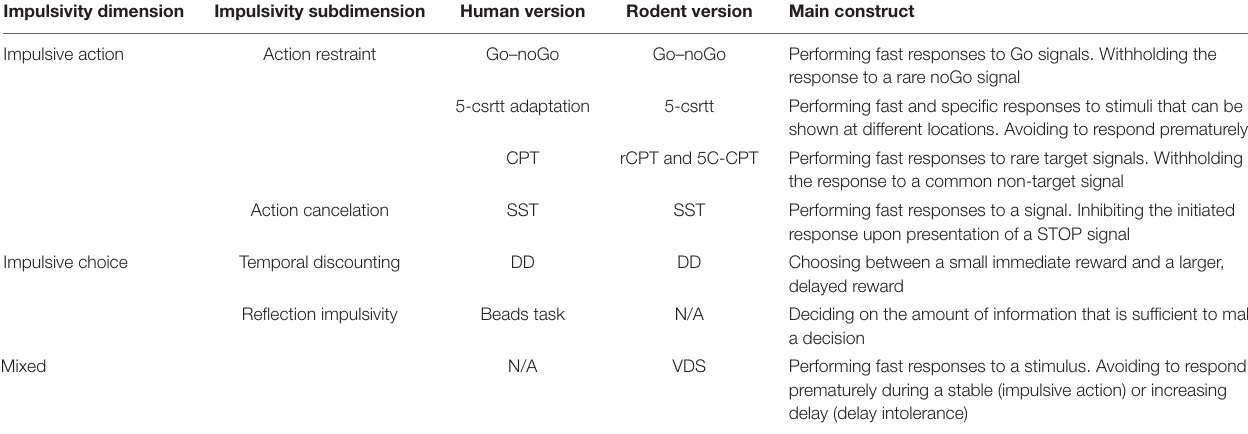
TABLE 1 | Behavioral measures of